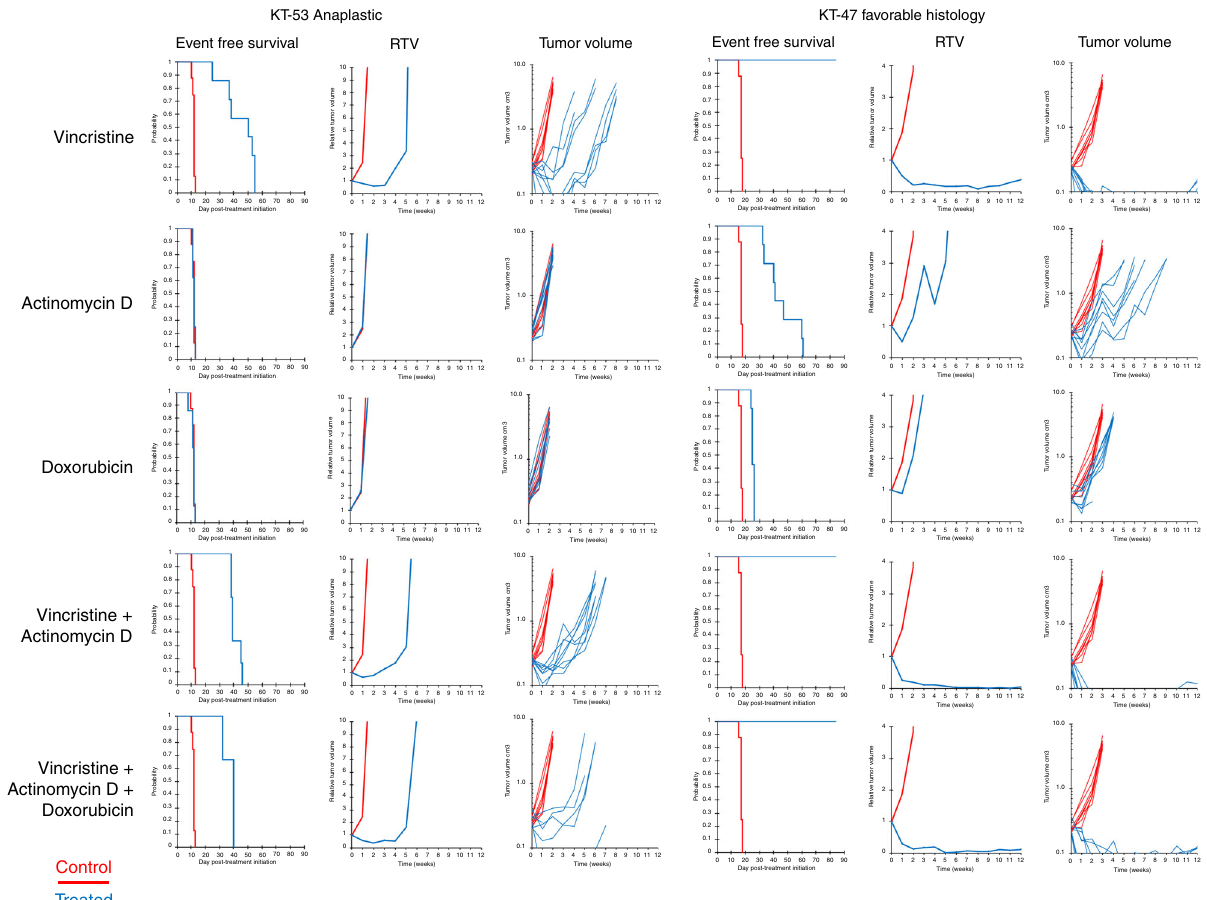
Fig. 7 Treatment responses in anaplastic versus favorable-histology WTPDX. The Children ’ s Oncology Group (COG) EE-4A regimen is modeled by the vincristine and actinomycin-D 2-drug combination treatment, and the COG DD-4A regimen is modeled by the vincristine, actinomycin-D, and doxorubicin 3-drug combination treatment. RTV — median relative tumor volume (cm 3